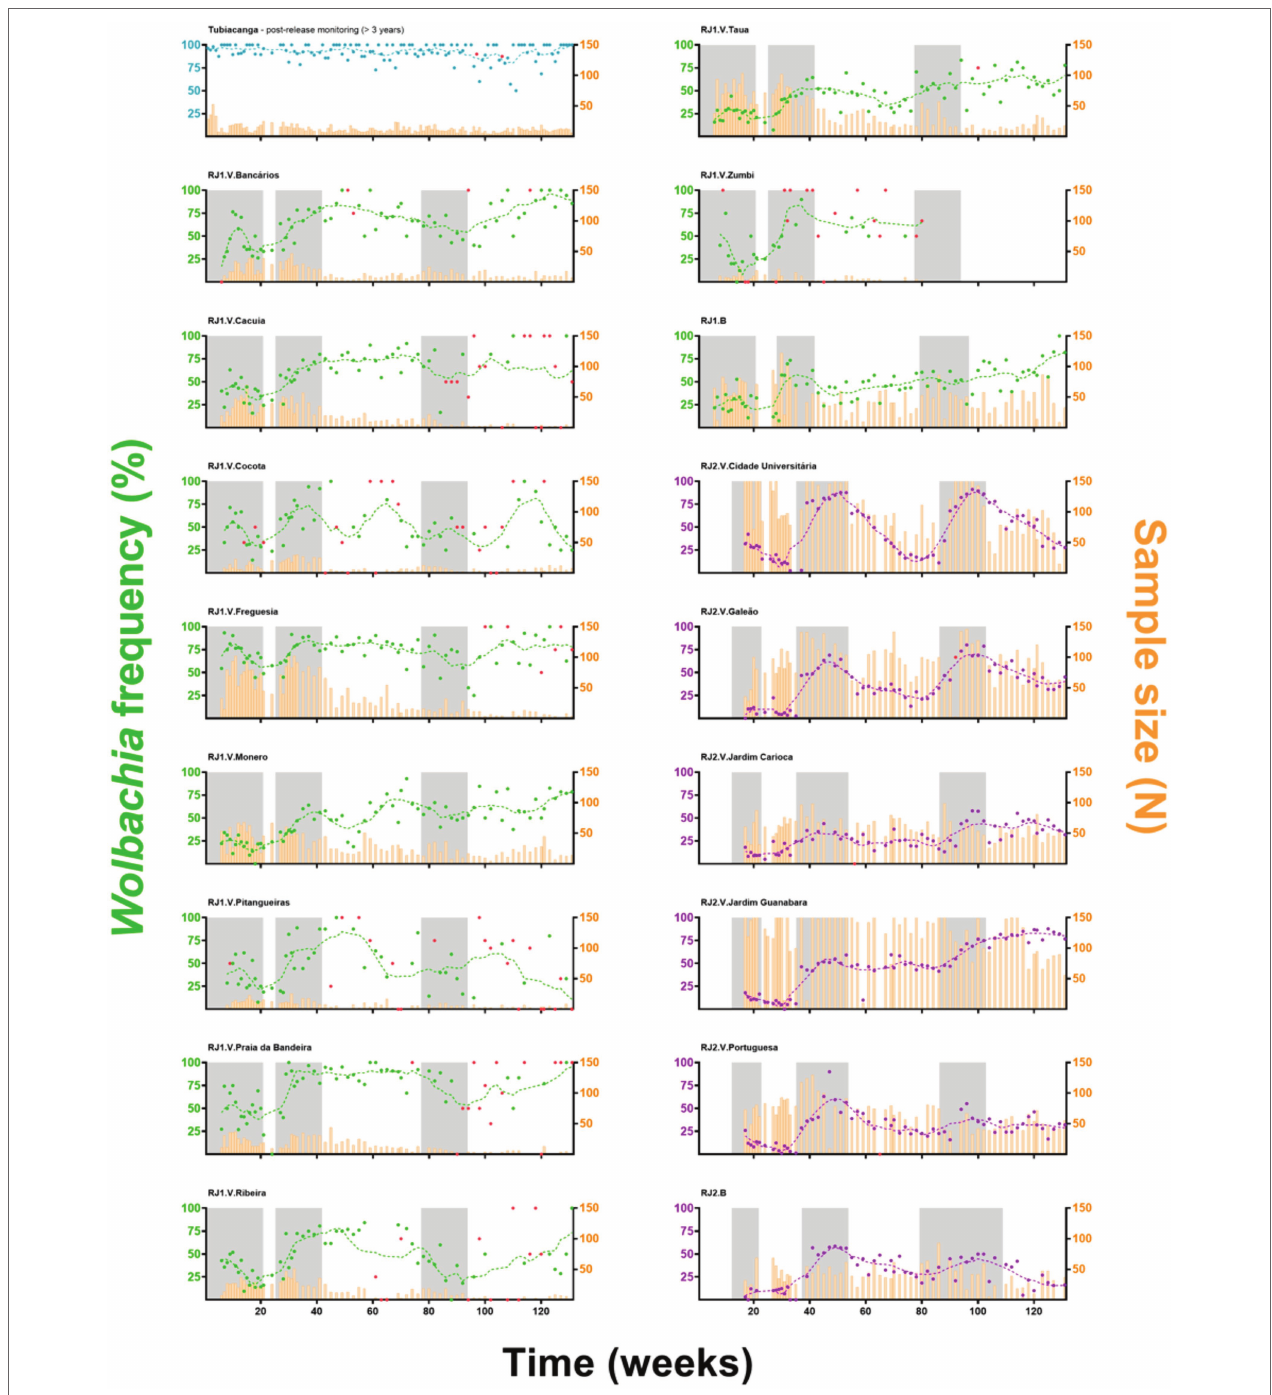
FIGURE 3 | Wolbachia ’s invasion profiles in individual neighborhoods. Adult w Mel-harboring Aedes aegypti were released (gray shading) across all neighborhoods of Ilha do Governador. Individual invasion profiles are depicted, with “RJ1” (green) or “RJ2” (purple) coding for the intervention area, and “V” or “B” for vehicle or backpack-assisted releases, respectively. Wolbachia prevalence indexes (%) are color coded and represented by dots plus second degree, seven-neighbors, moving averages (dashed lines), following the left Y-axis. Sample sizes are plotted as histograms (orange), following the right Y-axis. Prevalence indexes from small- sized samples (N < 5) are marked in red. The X-axis represents time (weeks), since the beginning of adult releases (Week1, August 2017) until recent days of field monitoring (Week 131, March 2020), with ticks scaled accordingly to represent 20-week bins. Post-release Wolbachia prevalence in Tubiacanga (blue), a previous intervention site, is shown as a standard for long-term field